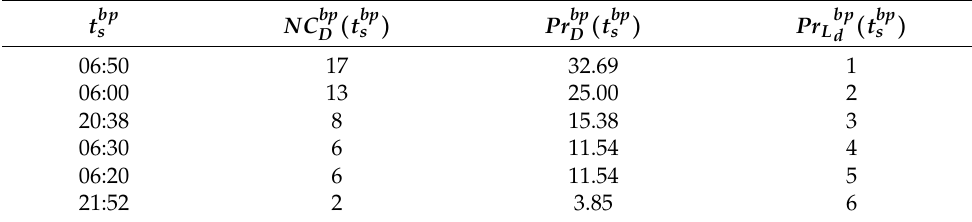
Table 6. Priority level values for t bp s for Scenario